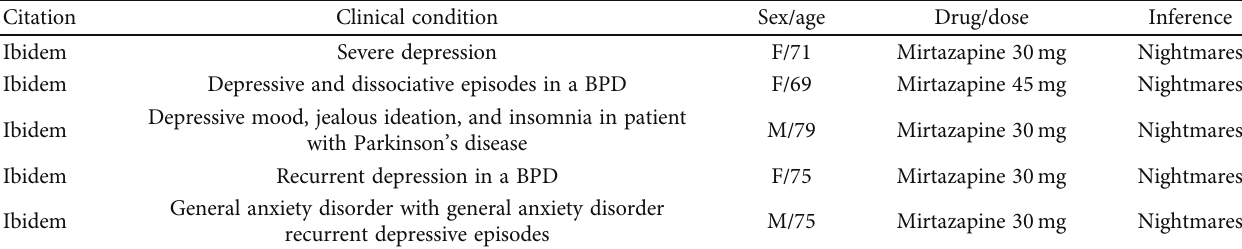
Table 2: Summary table of the cases